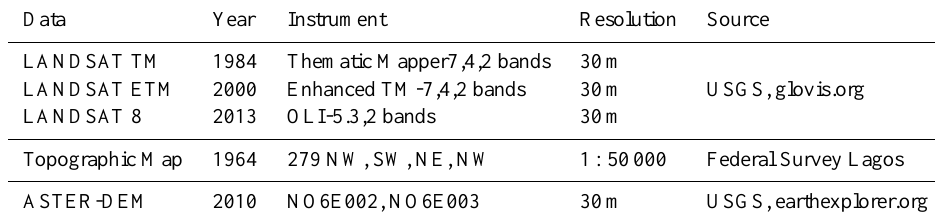
Table 1. Data sources and characteristics.